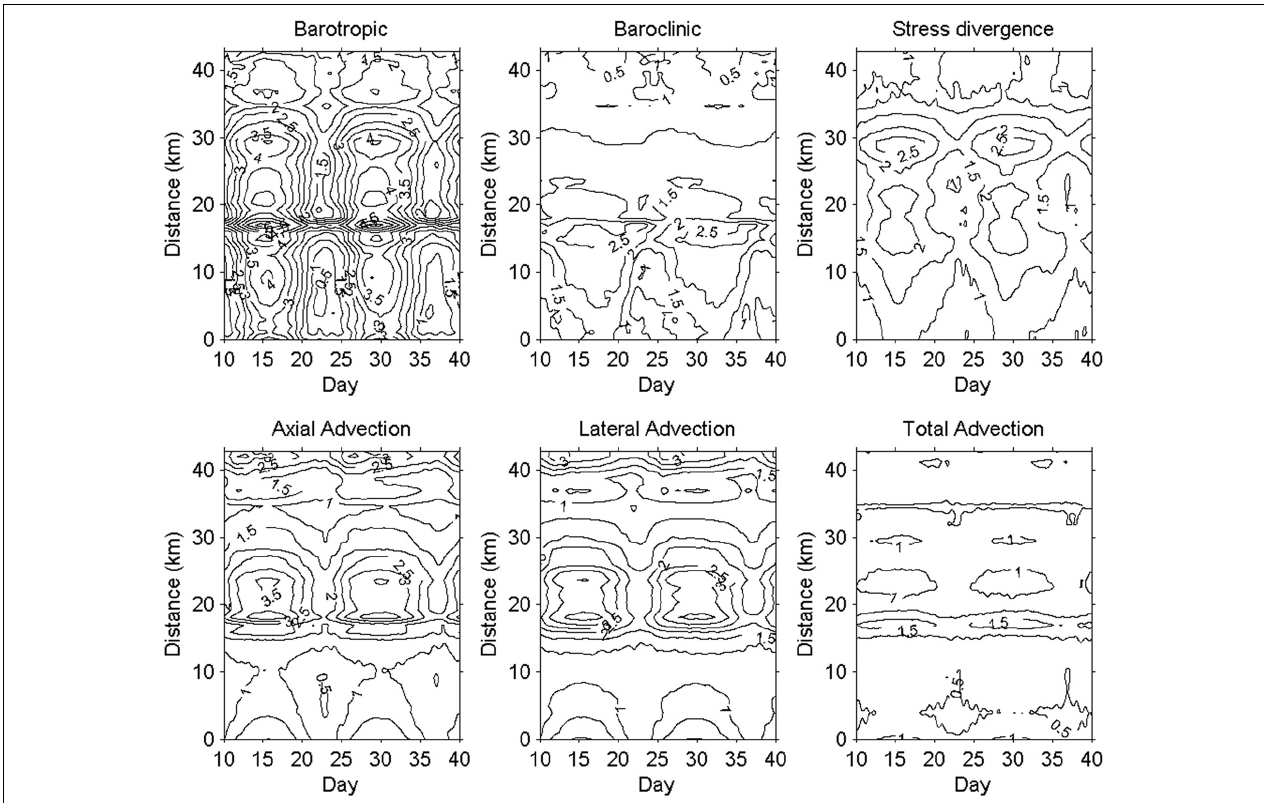
FIGURE 4 | Temporal variations in section-averaged absolute values of tidally averaged momentum terms along the western channel ( × 10 - 5 m 2 /s). The upper three panels represent barotropic pressure, baroclinic pressure, and stress divergence. The lower three panels represent axial, lateral, and total advections. The total advection is calculated from section-averaged absolute values of the sum of axial and lateral advections. The y-axis represents the distance from the lower (0 km) to the upper (44 km)